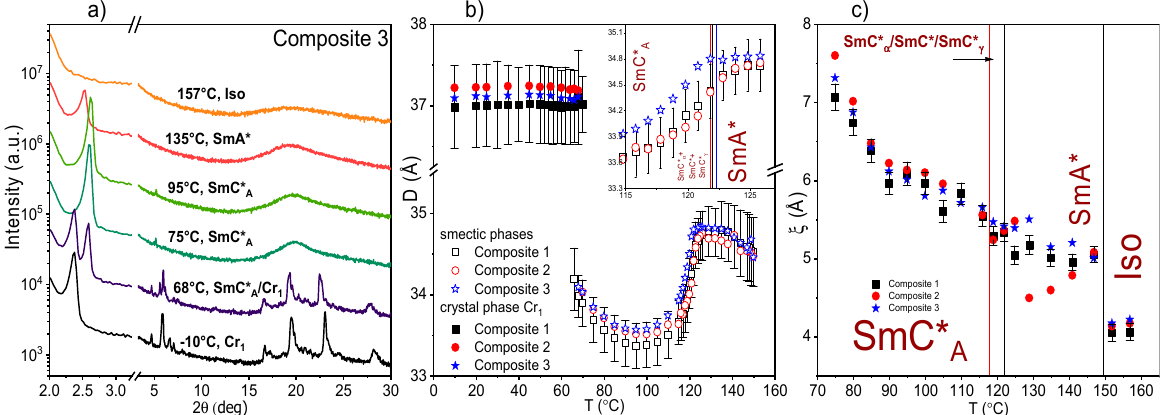
Figure 4. Diffraction patterns at several chosen temperatures as an example for Composite 3 ( a ), the temperature dependence of the smectic layer spacing/interplanar distance in a crystal phase ( b ), and the correlation length ( c ) on cooling for all Composites. The inset in ( b ) shows the high temperature range with colored lines representing the SmA*–SmC* α phase transition temperature obtained by DSC method for all